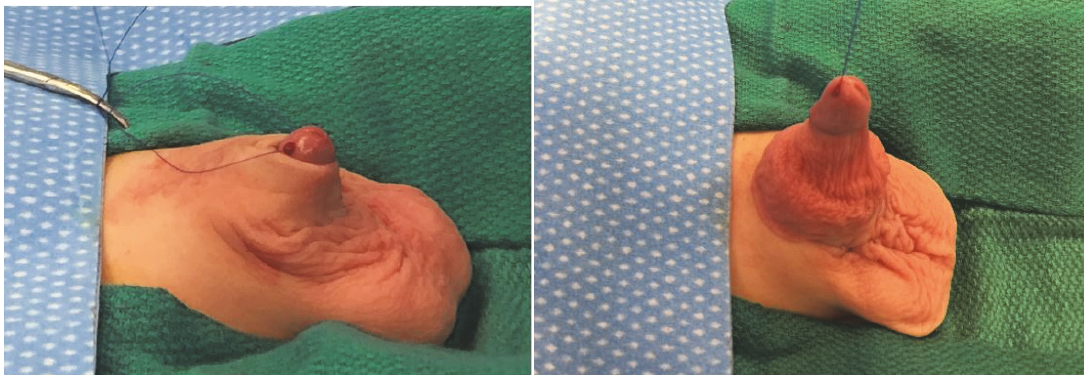
Figure 1: (a) shows the buried penis in normal position. (b) further details the extent of the excess inner prepuce.